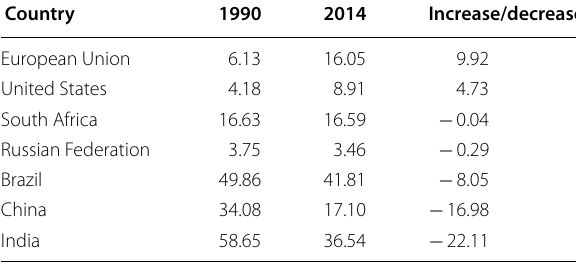
final energy consumption) Source: World Bank, Sustain- able Energy for All database (https ://data.world bank.org/ indic